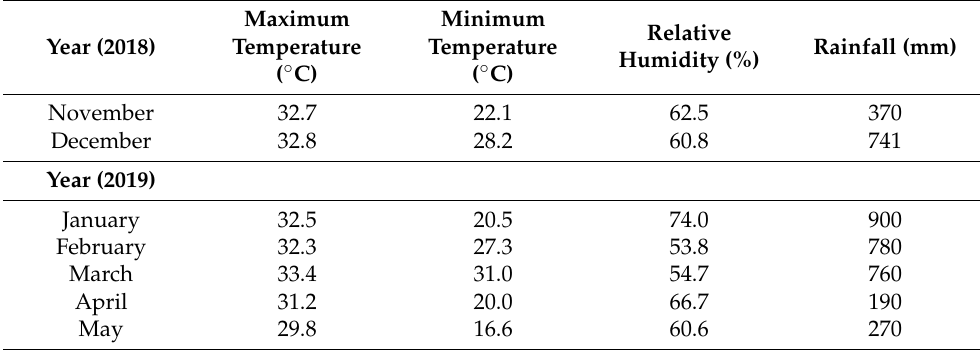
Table 1. Average temperature, relative humidity and total rainfall registered during the field experi- ment